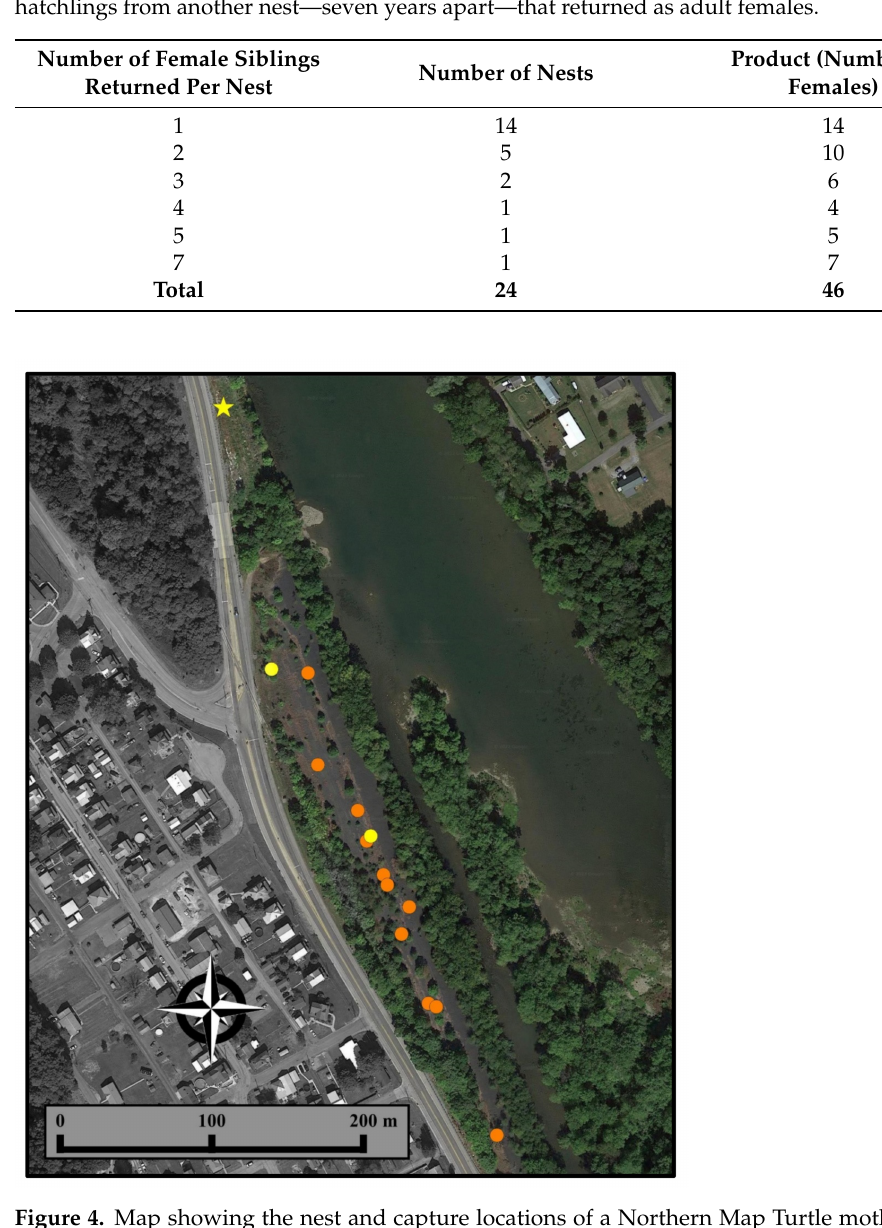
Figure 4. Map showing the nest and capture locations of a Northern Map Turtle mother and her returning adult daughters at Mount Union, Pennsylvania. A yellow star indicates the initial nesting location of female ABHP in 2000 along the turtle fence; yellow dots show recapture locations of ABHP in 2020 and 2022 on the coal pile; and orange dots show the recapture locations of her seven adult daughters that returned in 2017–2022 at ages 17–22 on the coal